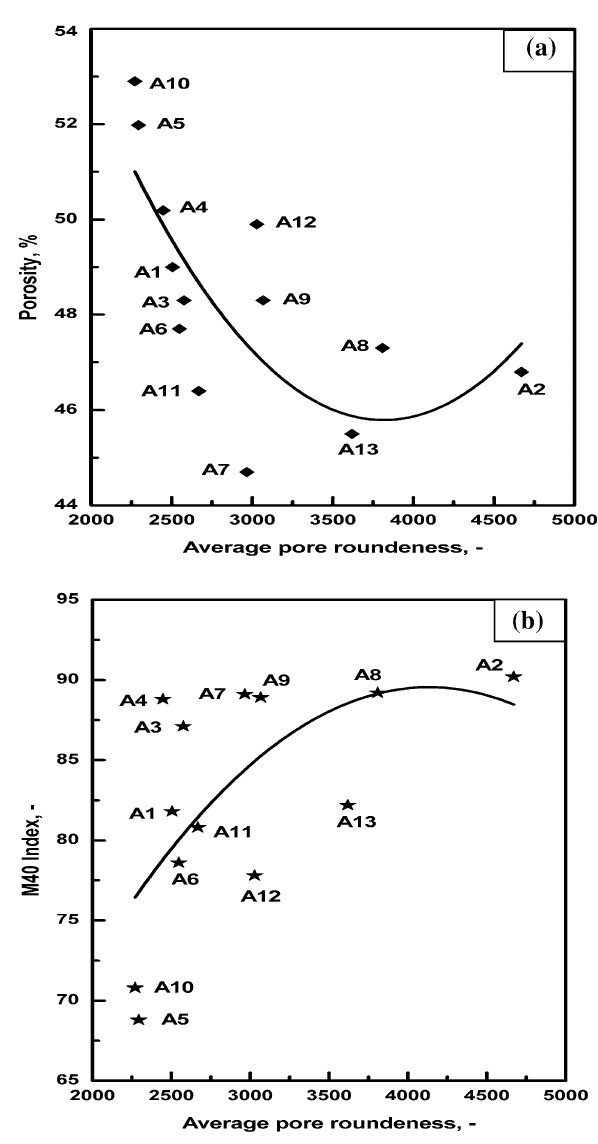
Fig. 6 a Relationship between average roundness of pores and porosity % (image analysis), b relationship between average round- ness of pores and M 40 index